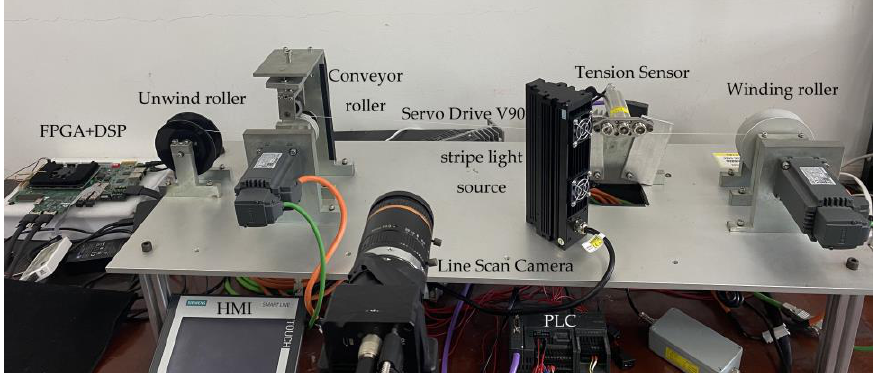
Figure 13. Construction of the experimental platform.